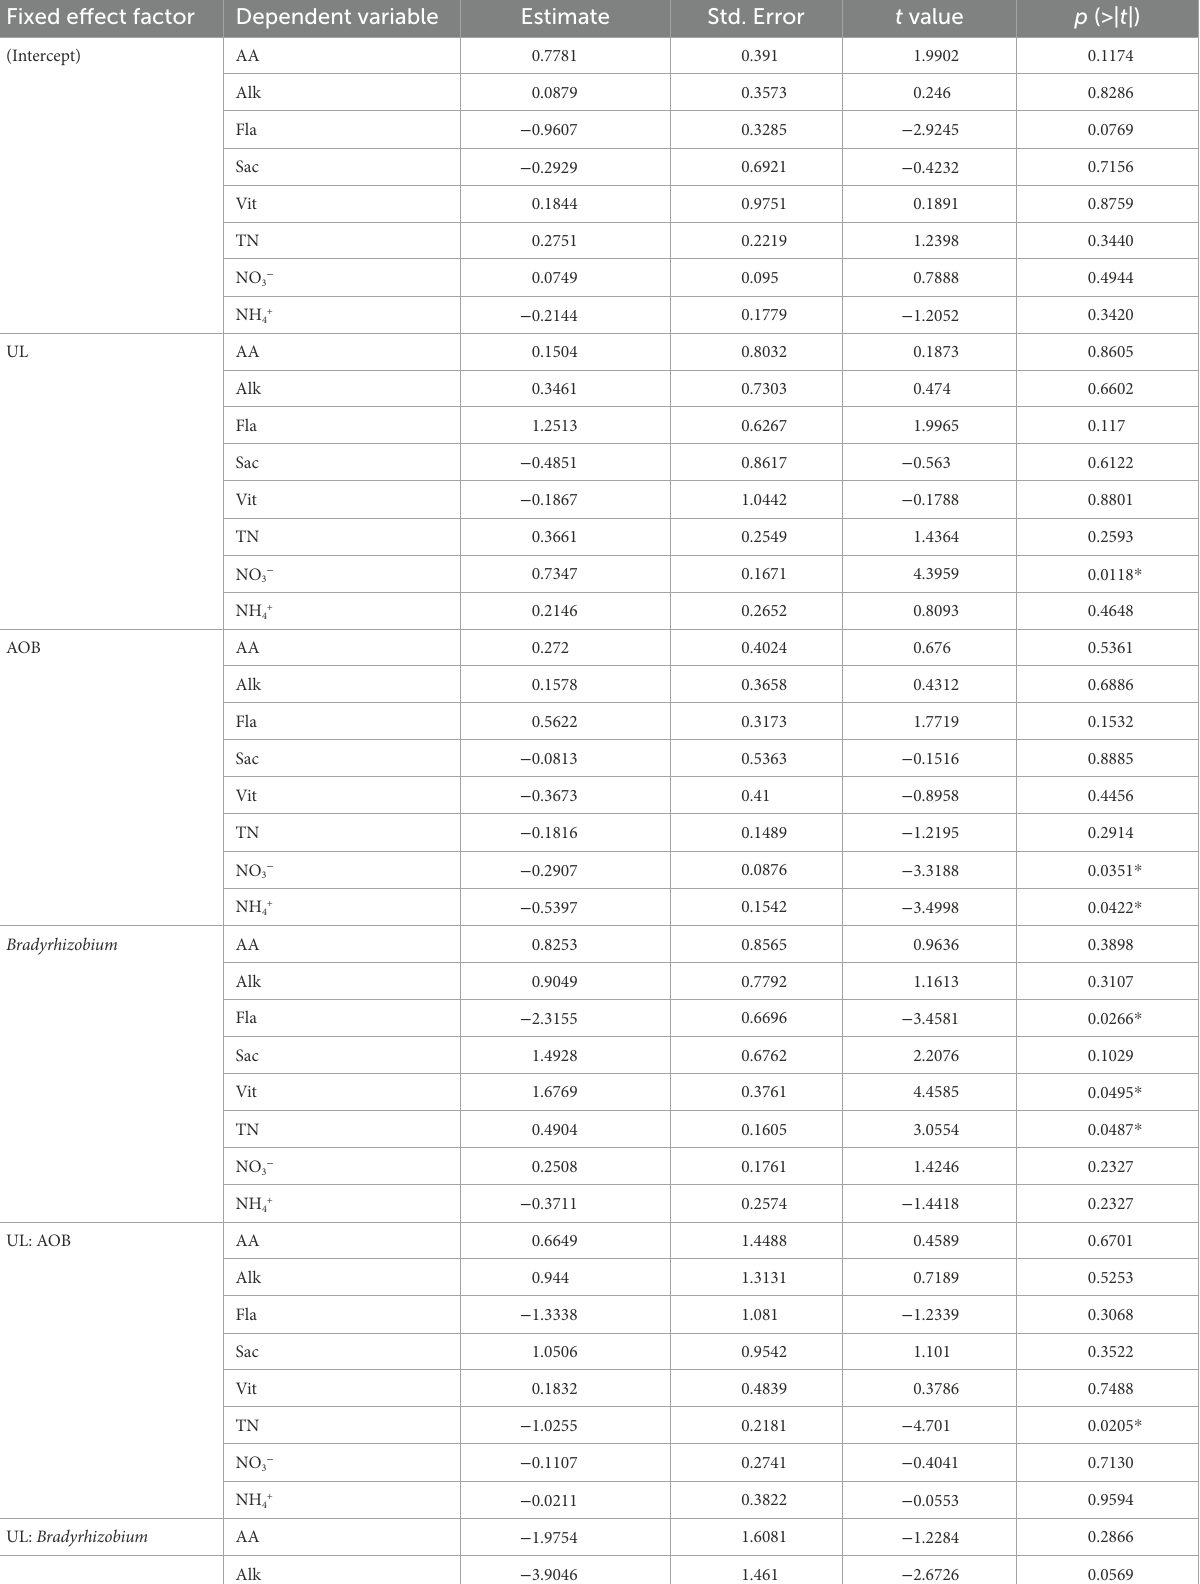
TABLE 2 Effect of various ecological variables on the nutrient content of fruit and soil nitrogen content as estimated by GLMM showing significant effect on the final best fitting